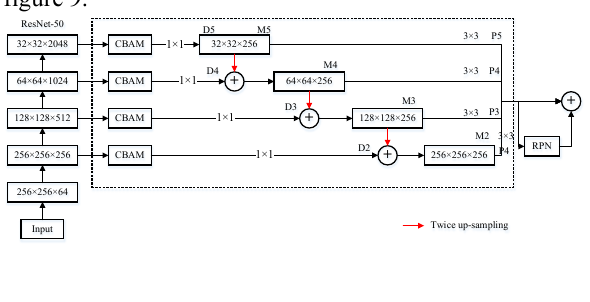
Figure 9. Structure of